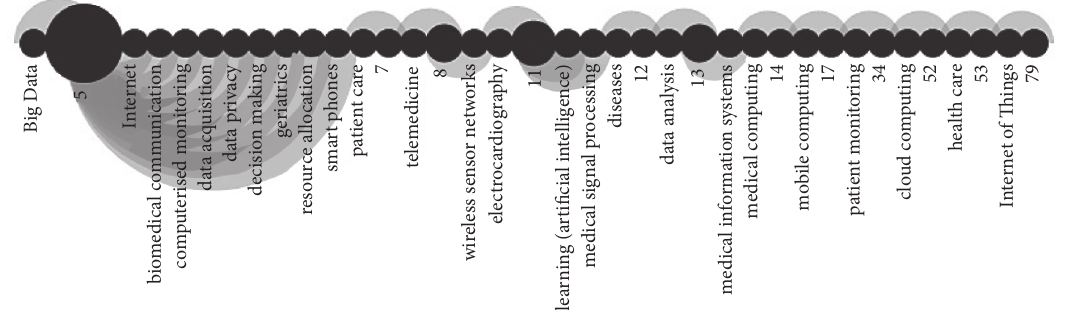
Figure 7: Publication topics and